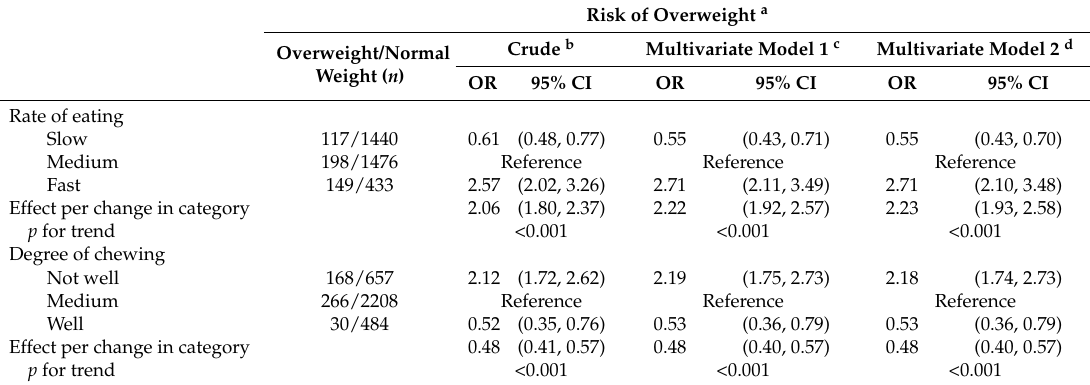
Table 3. Relationship of eating rate and degree of chewing with prevalence of being overweight among Japanese preschool children.